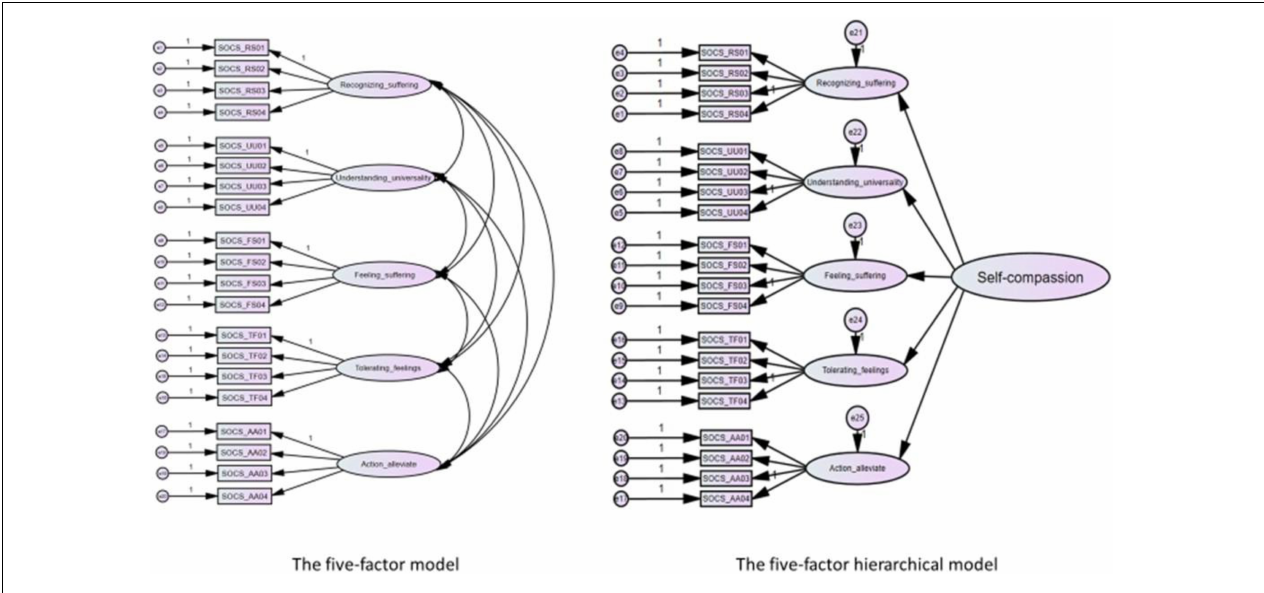
FIGURE 1 | The five factor model and the five-factor hierarchical model of the SOCS-S.